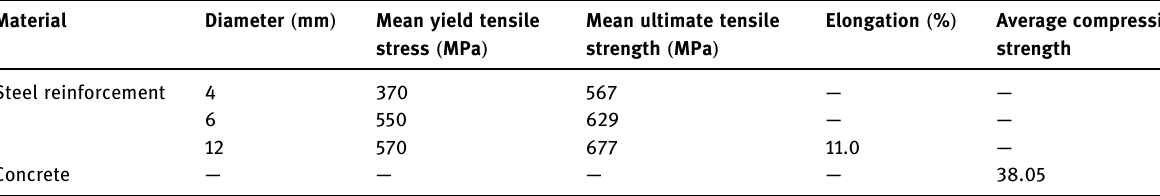
Table 3: Tensile characteristics of the investigated steel reinforcing bars Material